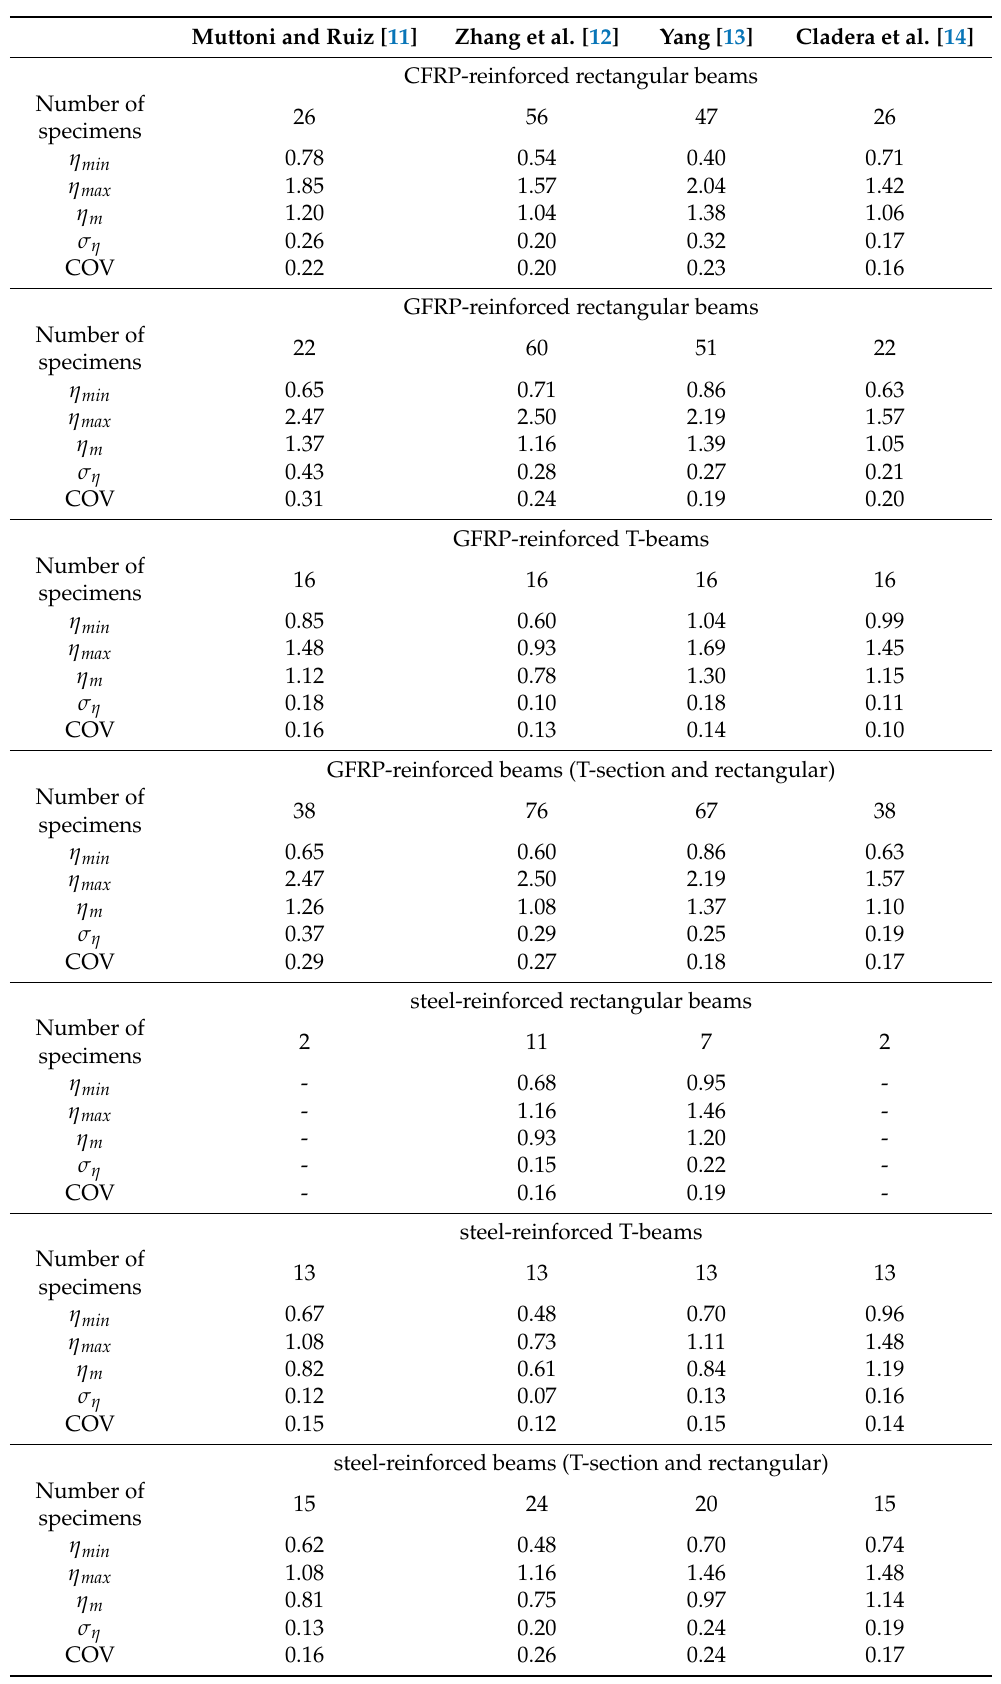
Table 2. Statistic assessment of design models with